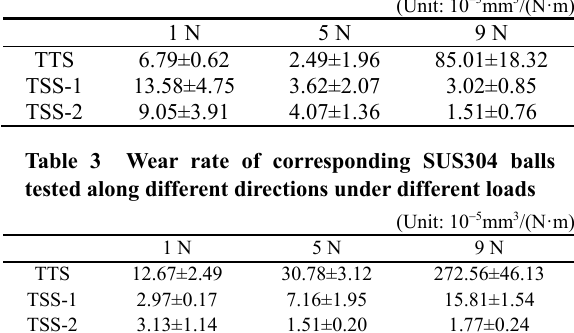
Table 2 Wear rate of textured Ti 3 AlC 2 ceramic tested along different directions under different loads